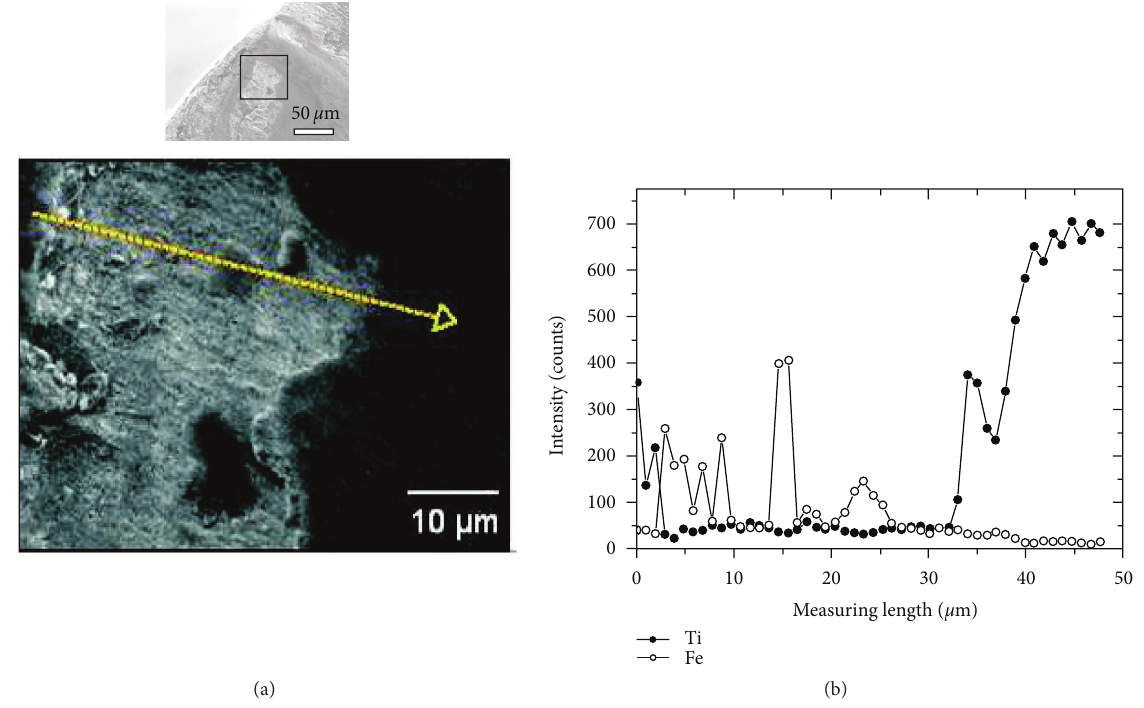
Figure 8: (a) SEM image worn rake face of TiN-coated cutting tool: 𝑣 𝑐 = 150 m/min, 𝑓 = 0.20 mm/rev, and 𝑎 𝑝 = 0.1 mm. The arrow depicts the path of the EDX line scan shown in